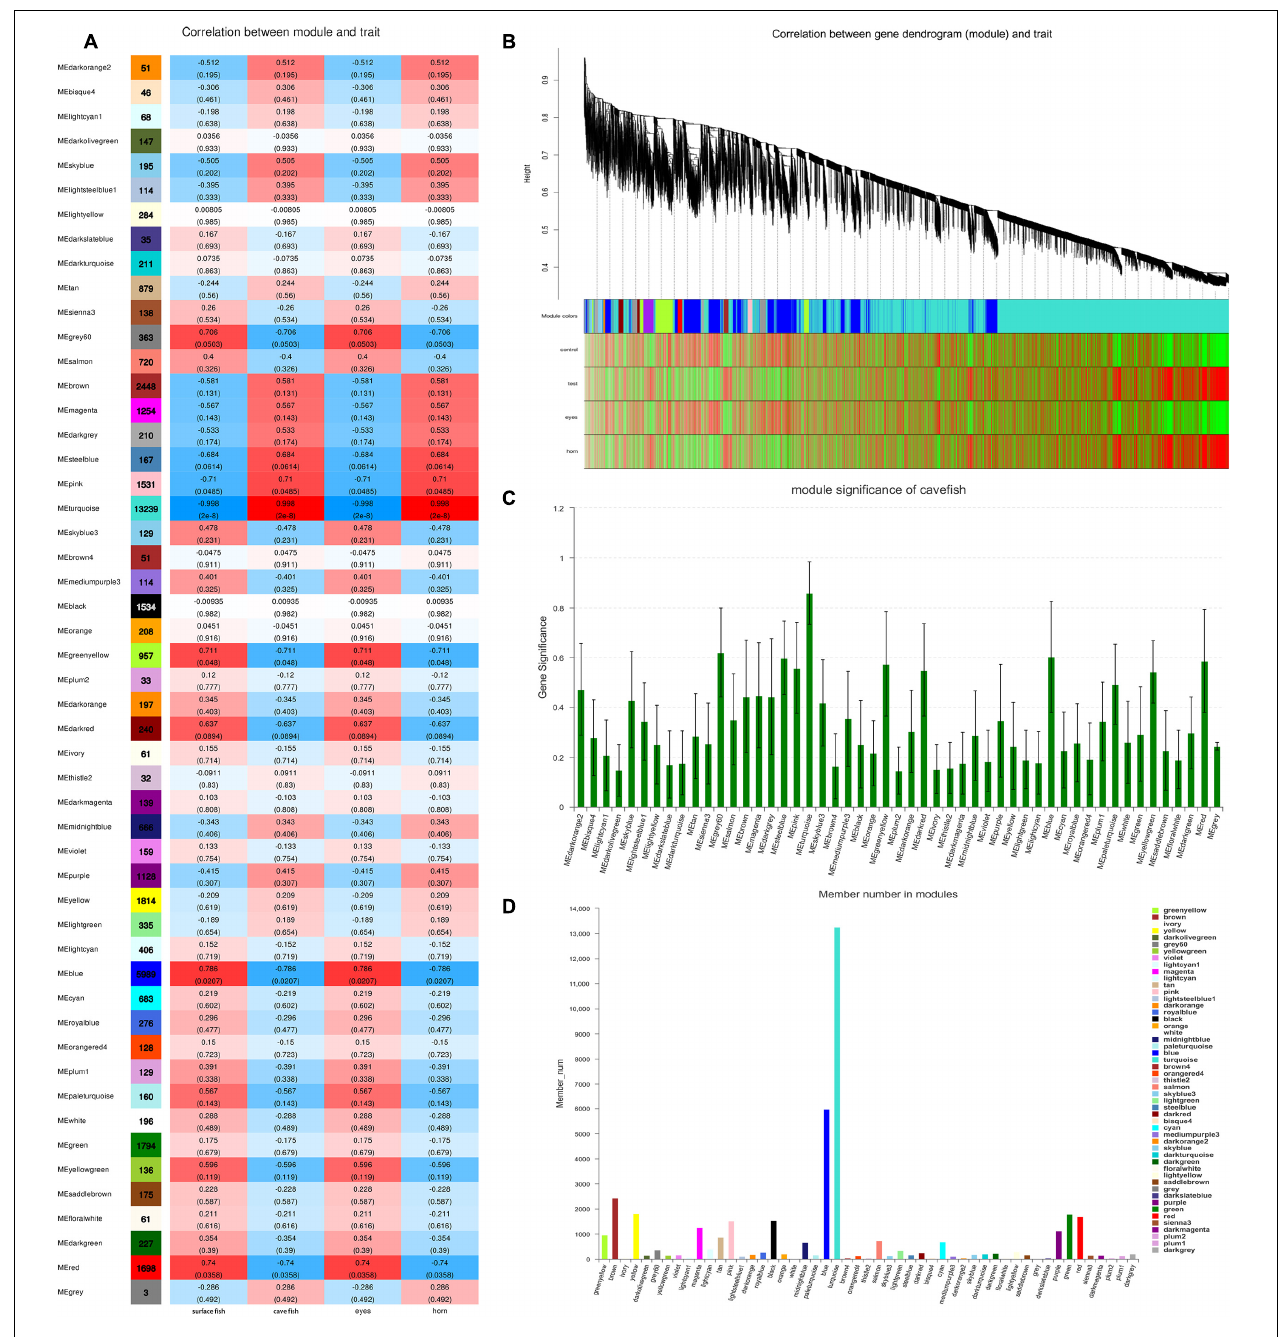
FIGURE 7 | Weighted Gene Co-expression Network Analysis of Genes Correlated with troglomorphic traits. (A) The correlation between modules and traits; The number in the left column indicates the number of genes in each module; The data in the heat map on the right represents the correlation coefficient between the module and traits and P value (parentheses). The deeper the red (positive correlation) and blue (negative correlation), the greater correlation between the module and traits, respectively. (B) Clustering of the genes which correlated with troglomorphic traits. Distance is based on topological overlap, the bottom heat map indicates the signed correlation of each gene with traits: red, positive correlation; green, negative correlation. (C) Module significance, X -axis is the module and the Y -axis is the value of gene significance (GS). The larger GS value indicates a greater correlation with traits. (D) gene number in each module.